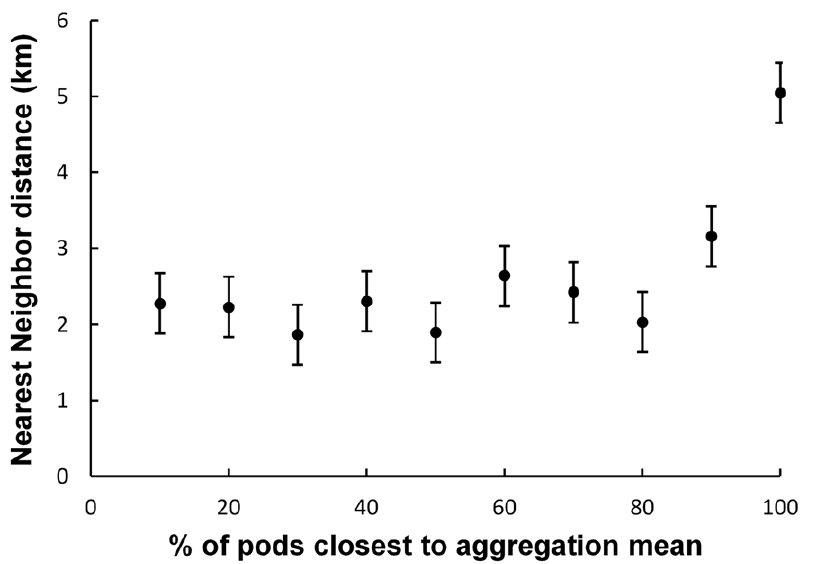
Figure 3. A comparison of nearest neighbour distances with proximity to the centre of aggregation. The nearest neighbour distance (mean of flights 6 standard error) of groups of pods based on how close they are to the centre of aggregation, i.e. the 10% mark contains the closest 10% pods to the mean, the 20% mark contains the closest 10–20%, and so on up to the 90–100% group. The only group with a significantly different nearest neighbour distance was the 90–100%, which was much higher than the rest.